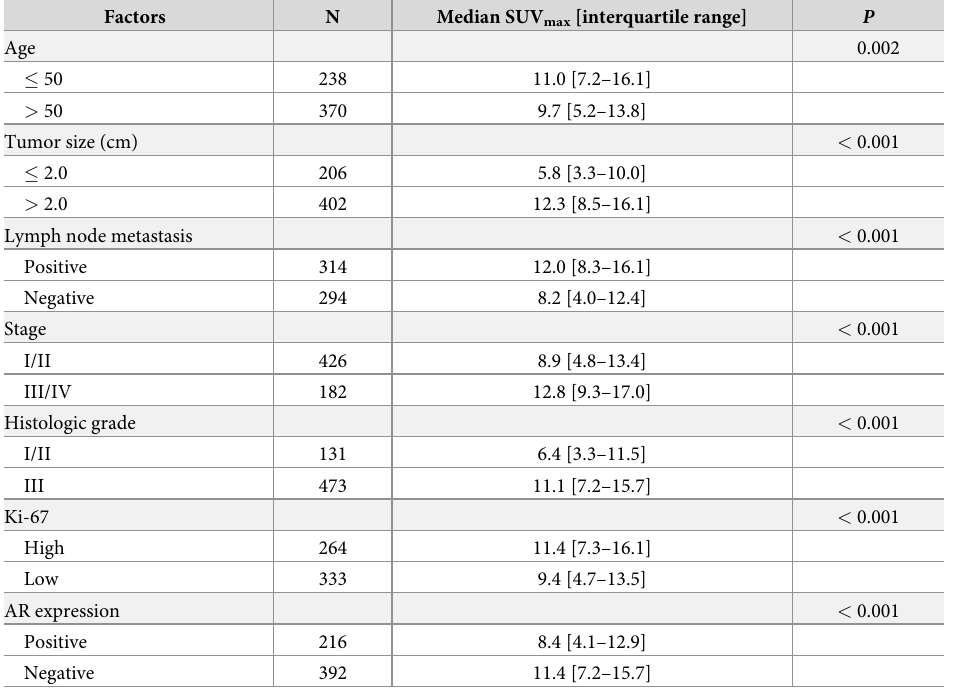
Table 3. FDG uptake according to various clinicopathologic